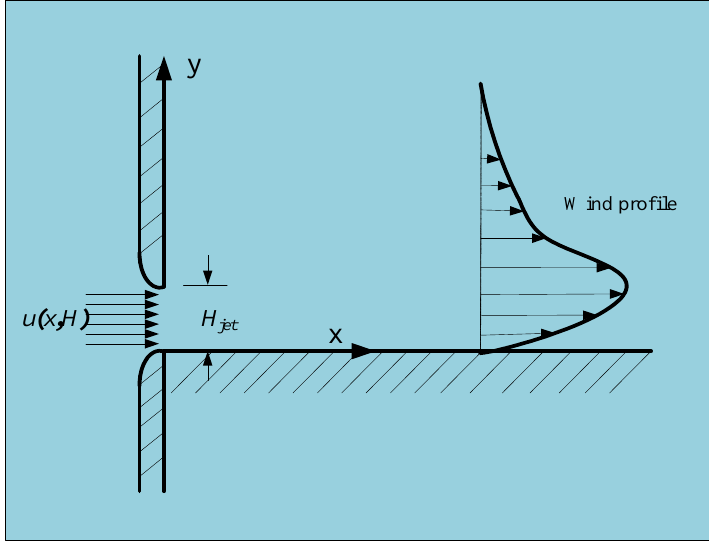
Figure 4. Diagram of the plane wall jet.